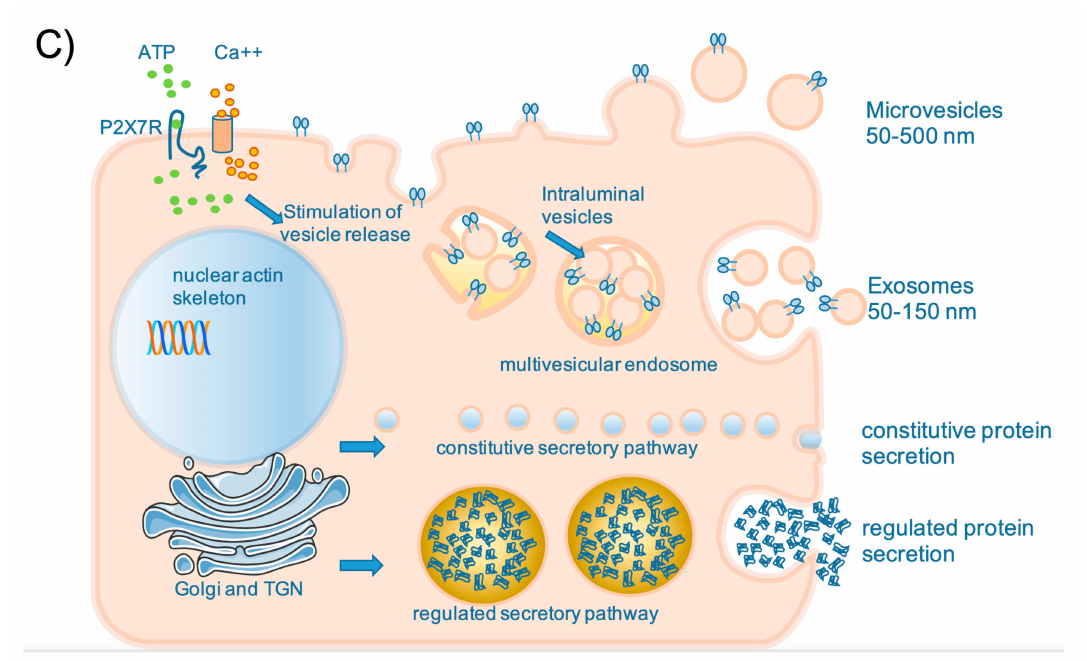
Figure 2. Mechanisms of mechanotransduction. Graphical summary of the current knowledge on the transduction of mechanical signals into a cellular response. A ) Mechanical strain applied to the cell and (the resulting) fluid flow activate receptors and channels and their downstream signaling cascades. In a tissue context, strain is transmitted between cells via a series of adhesion molecules such as integrins, cadherins, and tight junctions. Transcription factors become nucleotropic and address DNA regulatory elements such as repressors, enhancers, and their specific DNA response elements. Adaptive transcription and translation are initiated and lead to changes in transcriptome, proteome, and especially the secretome to communicate with neighbors and distant tissues. The expression and secretion of extracellular matrix proteins as parts of the secretome are upregulated. As a consequence, the incoming forces and the resistive response to external forces are enhanced, and a new homeostasis situation is produced. Similarly, the production of proteins of the cytoskeleton is enhanced, the cytoskeleton is also becoming sti ff er, and the contractile proteins generate even more active forces. B ) Fluid flow is sensed by the primary cilium. The relevant structural features of a primary cilium are schematically depicted on the right side, while the signaling cascades and tools for mechanotransduction are depicted on the left side. Deflection of the cilium generates signaling [43,44]. Intraflagellar transport is a means of active transport of signaling peptides to and from the cell body. C ) The constitutive secretory pathway and the regulated secretory pathway are schematically depicted. While the latter has not been demonstrated in muscle or bone, it is characteristic for truly endocrine cells and requires complex sorting and the intravesicular storage of preformed proteins that are extruded upon endocrine signals. The constitutive pathway requires characteristic secretory peptide sequences to be continuously released into the extracellular environment and subsequently the circulation. The release of vesicles upon exercise-related calcium flux into the cell has been demonstrated to be a candidate mechanism for the release of proteins and miRNAs. Abbreviations: RTK: receptor tyrosine kinase; GPCR: G-protein coupled receptor; ATP: adenosine triphosphate; cAMP: cyclic